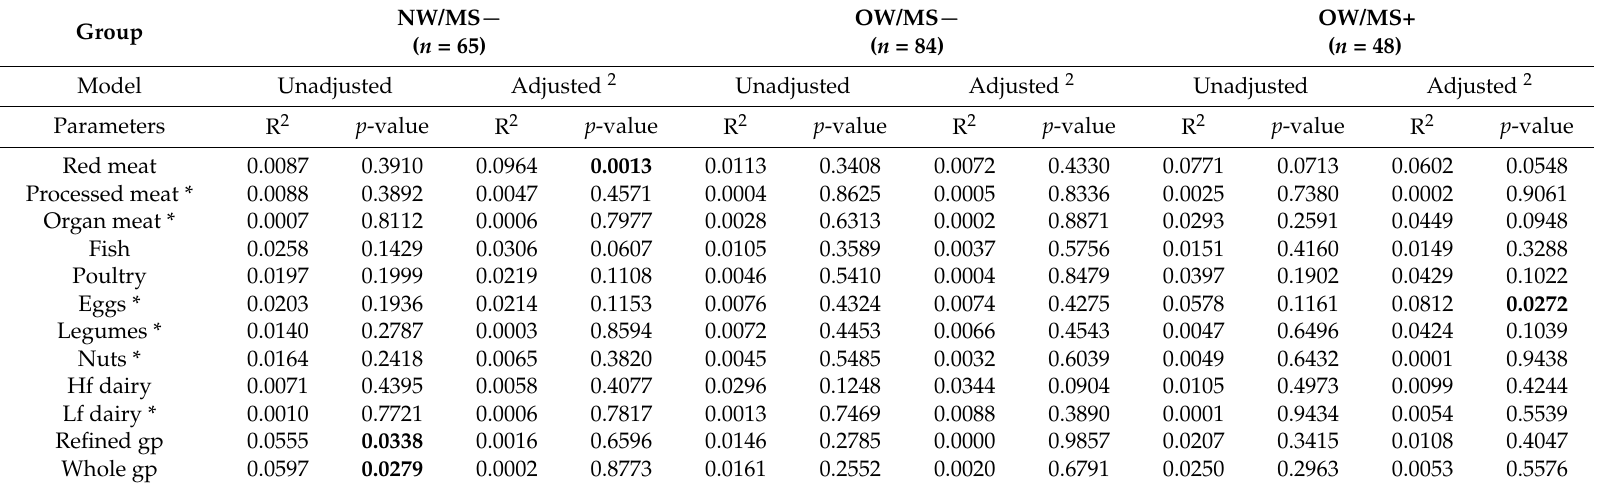
Table 4. Associations between all 12 principal protein sources and plasma BCAA levels in subgroups based on OW and MS status without and with adjustments for